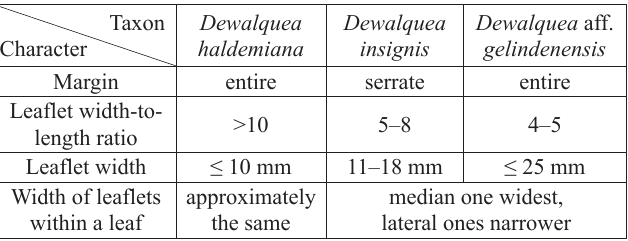
Table 1. Comparison of Dewalquea species present in the studied ma-